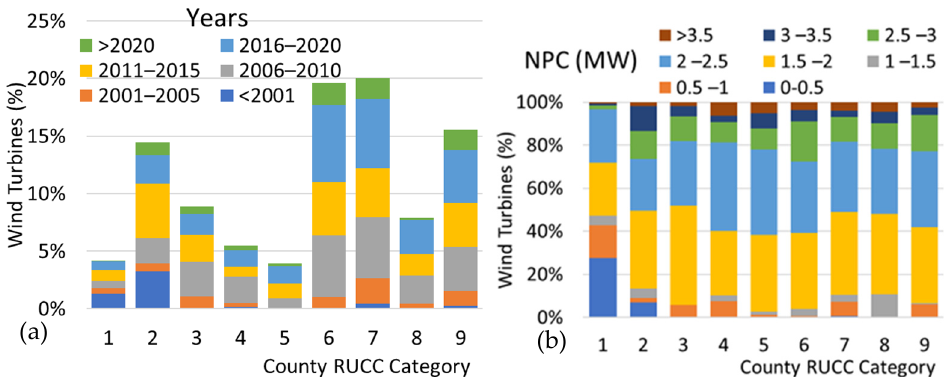
Figure 5. Wind turbines according to the USDA Rural–Urban Continuum Codes considering ( a ) the number (%) of wind turbines classified by installation year considering the ranges (in years) indicated in the chart legend and ( b ) the number (%) of wind turbines classified by NPC.